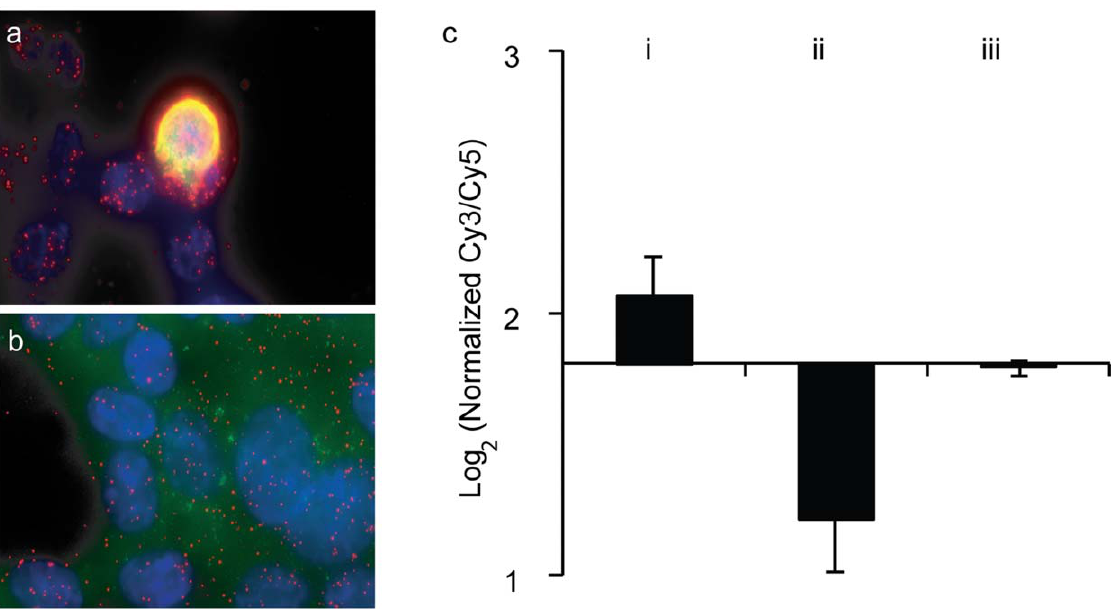
Figure 4. DTM readout of PLA on fixed cells. In situ PLA (red) and immunofluorescence (green) detection of SMAD4 in a ) cells transiently transfected with SMAD4 and b ) wt cells having only endogenous levels of SMAD4. c ) DTM readout of the ratios between SMAD4 from transfected cells and wt cells: transfected/wt (i), wt/transfected (a dye-swap experiment) (ii), transfected/transfected (iii), normalized against the ratio of beta-